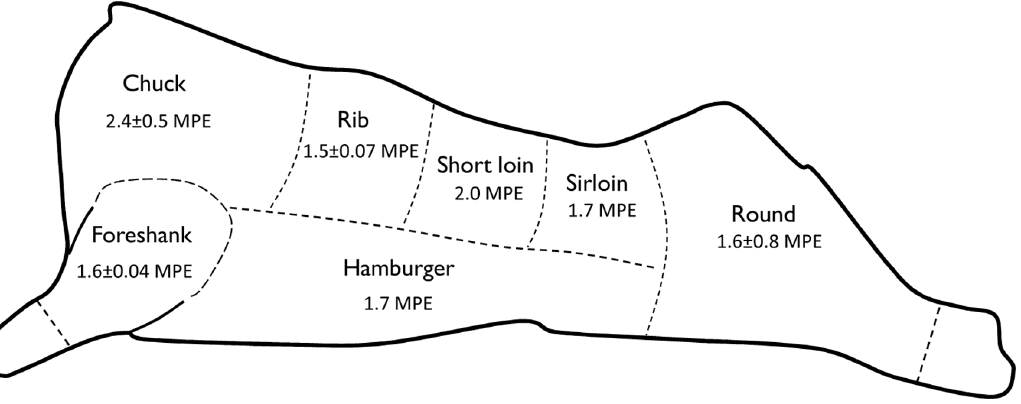
Figure 3. The L-[1- 13 C]phenylalanine enrichments of the meat cuts collected from different locations of a lactating dairy cow. The filet mignon is a steak cut that is, generally, positioned in the short loin steak cut . Values are expressed as mole percent excess (MPE).